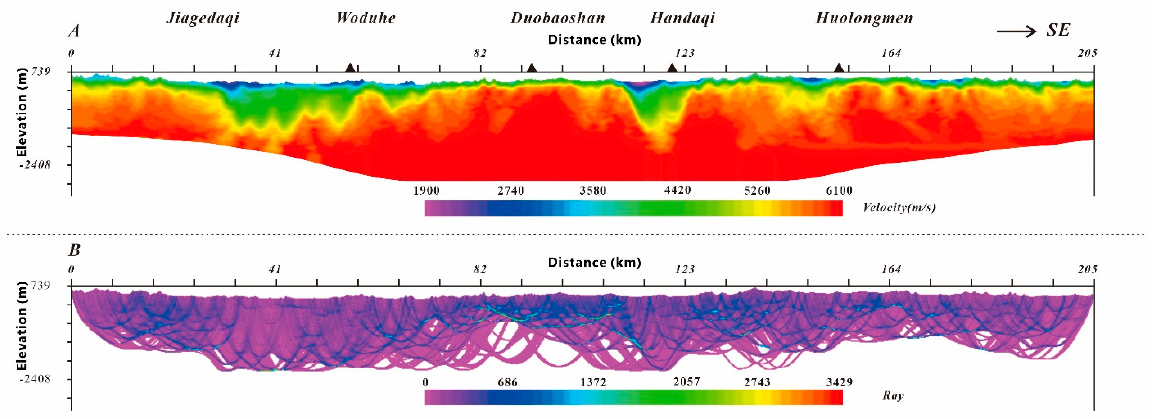
Figure 8. Tomographic inversion results. ( A ) Velocity profile of first ‐ arrival seismic tomography inversion. ( B ) Ray pathways of first ‐ arrival seismic tomography inversion.